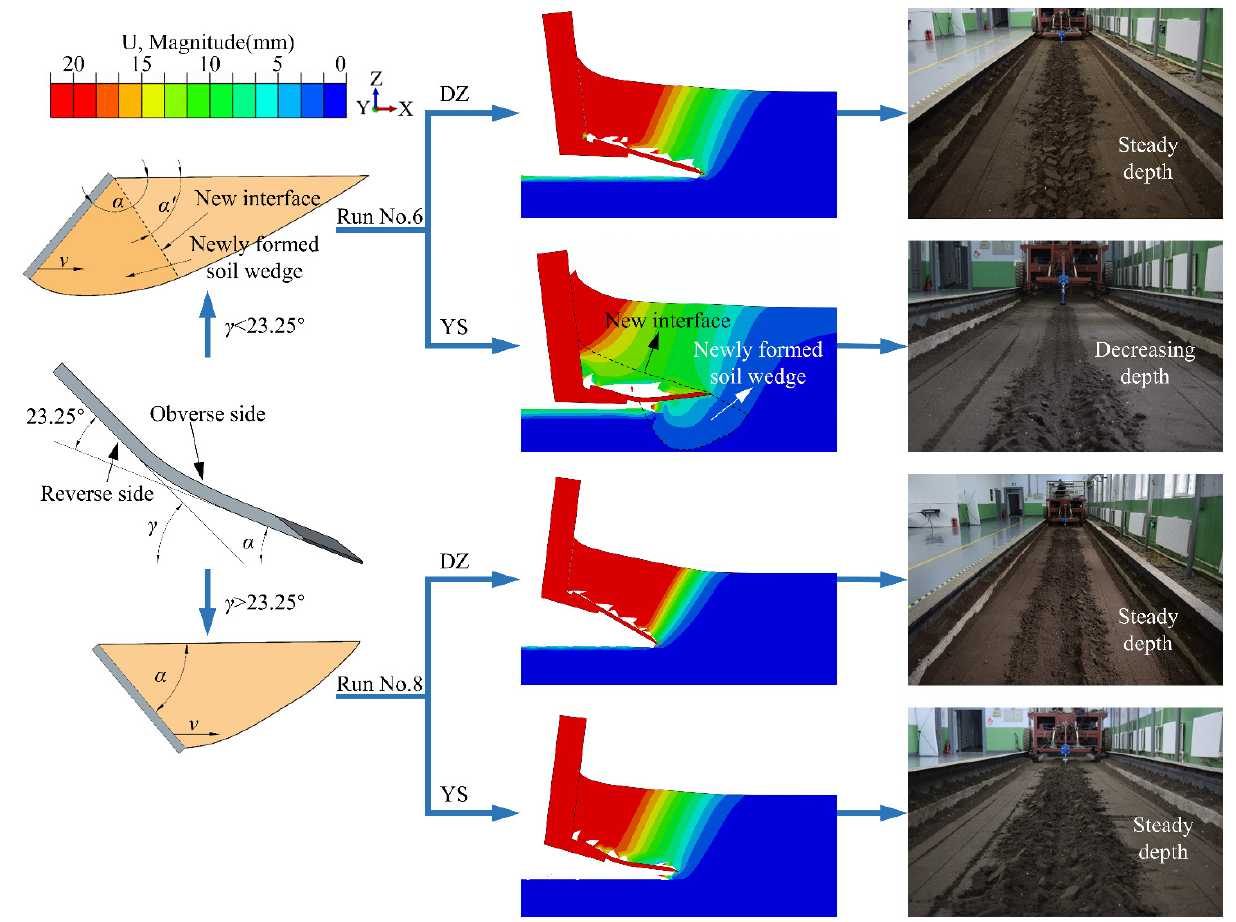
Figure 12. Soil failure at different mounting angles. Displacement contour (center) and ploughing tracks in soil bin experiments (right).